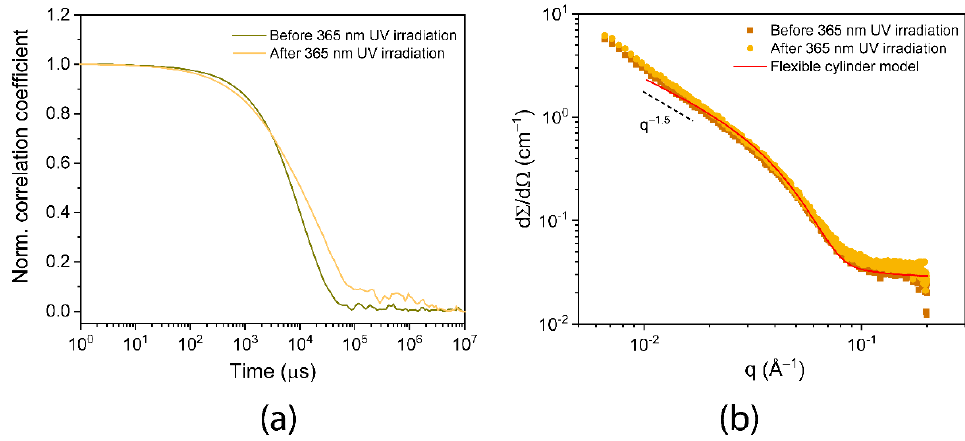
Figure 5. DLS (( a ), 1.0 mM) and SAXS (( b ), 10 mg/mL) measurements of OEG bis-urea amphiphile aqueous solution containing 10% Cou-crosslinker before and after UV irradiation (365 nm, 30 min).